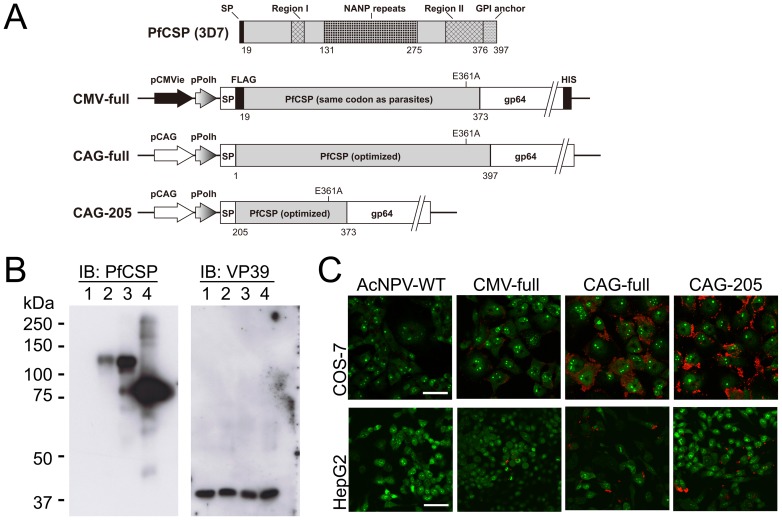
Schematic representation and expression analysis of BDES-PfCSP.(A) Expression of the PfCSP gene cassette was driven by the dual promoter, which consisted of the CMV immediate early enhancer-promoter (pCMV), or the CAG promoter (pCAG) as well as the polyhedrin promoter (pPolh). Both full-length pfcsp and the N-terminal truncated pfcsp were fused to the N terminus of the AcNPV major envelope protein gp64 gene (gp6421–512). All BDES constructs also had the endogenous gp64 gene in their genomes. SP, the gp64 signal sequence; FLAG, FLAG epitope tag; HIS, His epitope tag. (B) Western blot analysis of recombinant AcNPV particles. AcNPV-WT (lane 1), CMV-full (lane 2), CAG-full (lane 3) and CAG-205 (lane 4) particles were lysed, loaded onto an 8% gel and immunoblotted with the anti-VP39 Ab. The membrane was stripped and then reblotted with the anti-PfCSP mAb 2A10. (C) COS-7 cells and HepG2 cells were transduced with BDES-PfCSP at multiplicities of infection (MOI) of 500 and 100, respectively. After 48 hours incubation, such cells were stained with the 2A10 mAb conjugated to Alexa Fluor 594 (red). Nucleic acids in the cells were visualized by SYTO-13 (green). Bars, 50 µm.